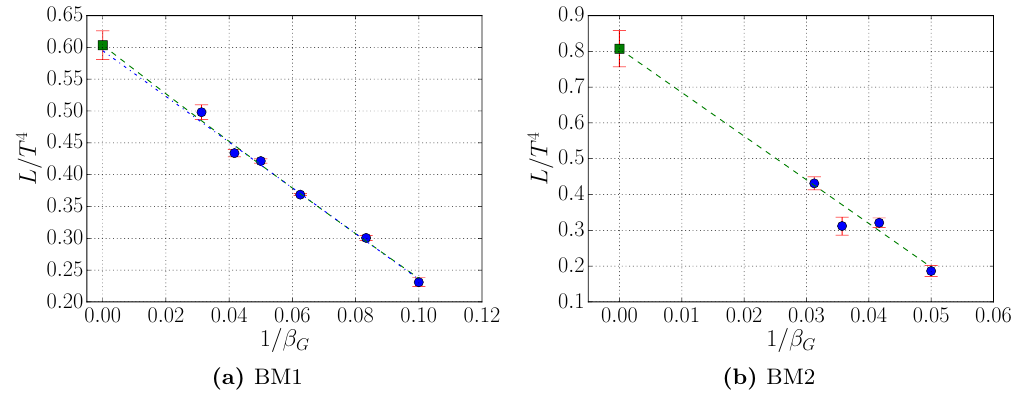
Figure 7. Continuum extrapolation of the latent heat. The behavior is similar to that of (cid:1) v=T , but with slightly larger statistical errors. In BM1, we again show both linear and quadratic (cid:12)ts.